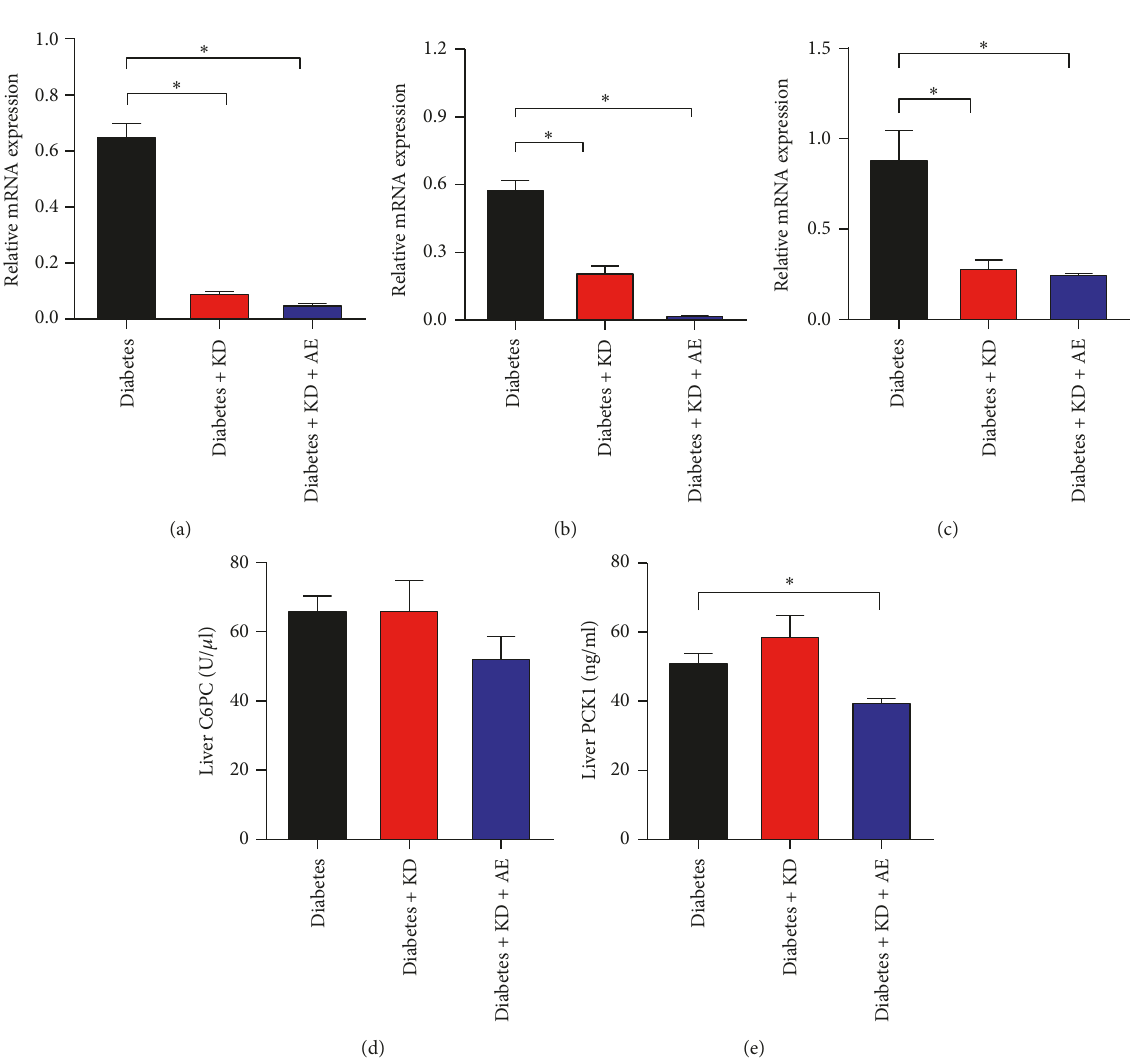
Figure3:Ketogenicdietandaerobicexerciseamelioratehepaticgluconeogenesisofdiabeticmice.(a)G6PC,(b)PCK1,and(c)FBPasemRNA expression levels in mice liver of the diabetes, diabetes + KD, and diabetes + KD + AE groups, after 6-week intervention. (d) G6PC and (e) PCK1 activity in mice liver of the diabetes, diabetes + KD, and diabetes + KD + AE groups, after 6-week intervention. Data were presented as means ± SEM ( 𝑛 = 6 per group). Statistical analysis was performed with 1-way ANOVA. ∗ 𝑃 < 0.05 versus diabetic